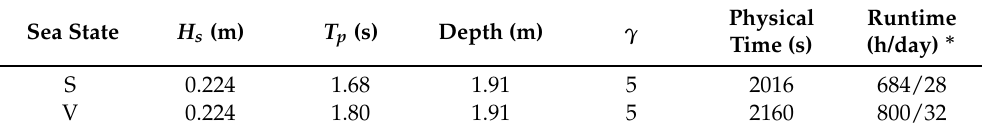
Table 2. Sea state environmental conditions for numerical